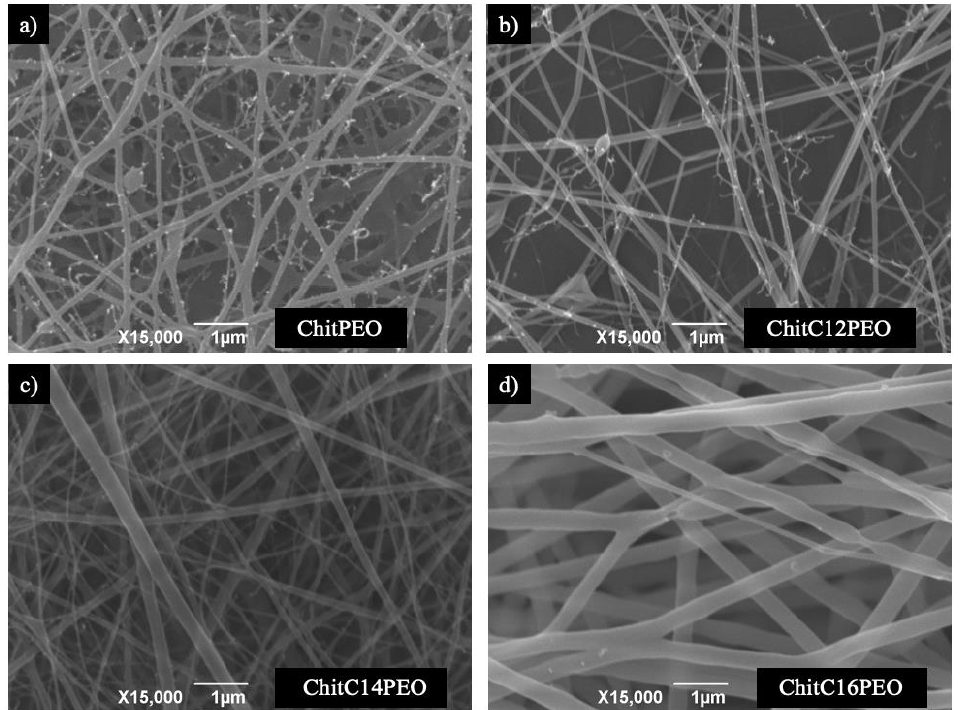
Figure 2. SEM images of: ( a ) matrix of ChitPEO; ( b ) matrix of ChitC12PEO; ( c ) matrix of ChitC14PEO over a layer of PEO; ( d ) matrix of ChitC16PEO over a layer of PEO.